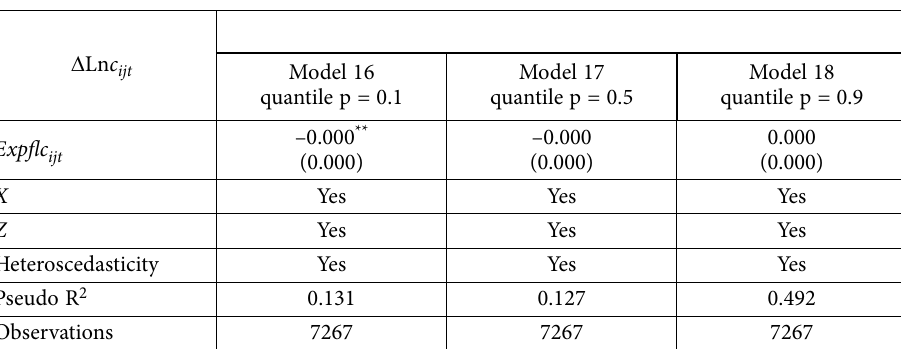
Figure 2. The change of quantile regression Table 9. Estimation results of quantile regression